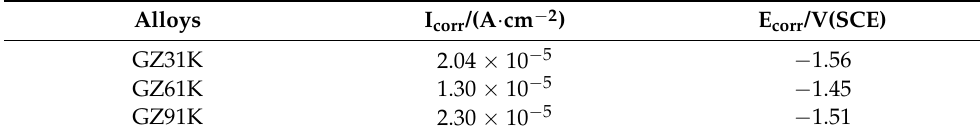
Figure 4. Polarization curves of T6-treated alloys in SBF. Table 3. Electrochemical parameters of the samples fitted from Figure 4.